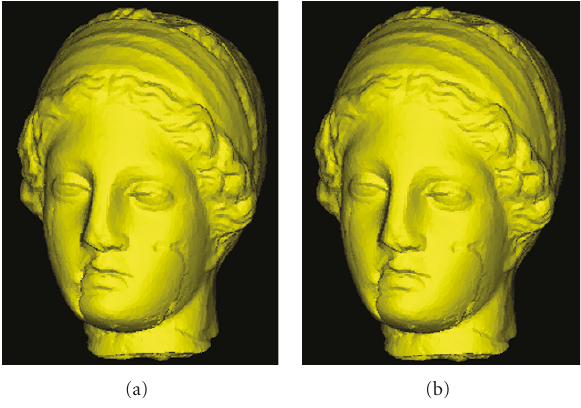
Figure 2: (a) Original model. (b) Watermarked model.